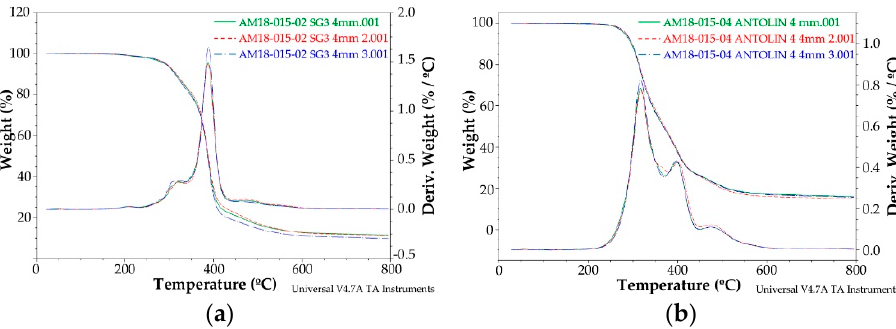
Figure 4. TGA of polyurethane (I) that come from the insulation industry for refrigeration from the Italpannelli factory.